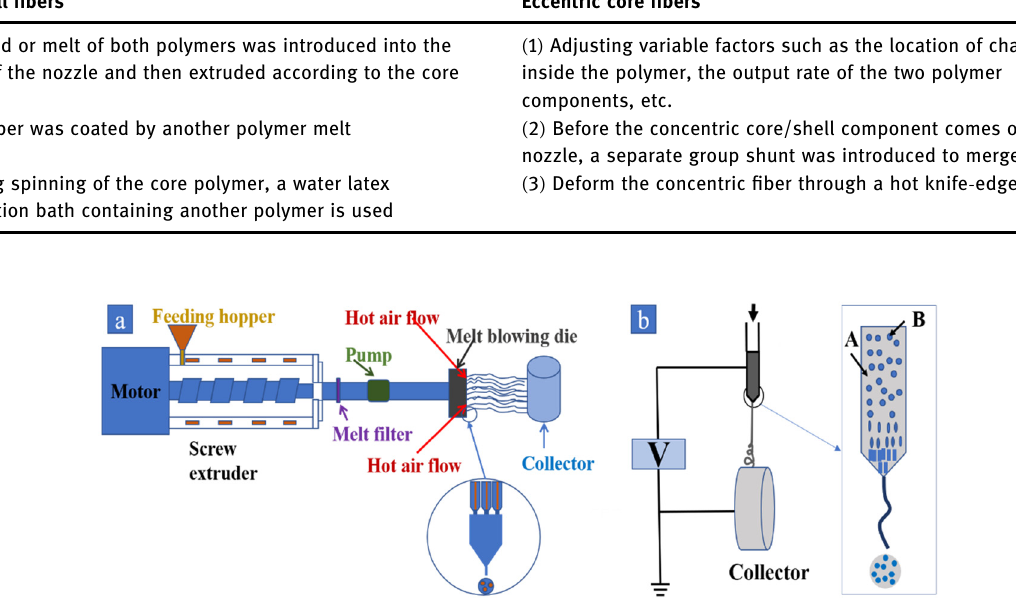
Table 2: Fabrication of core/shell bicomponent fi bers Core/shell fi bers